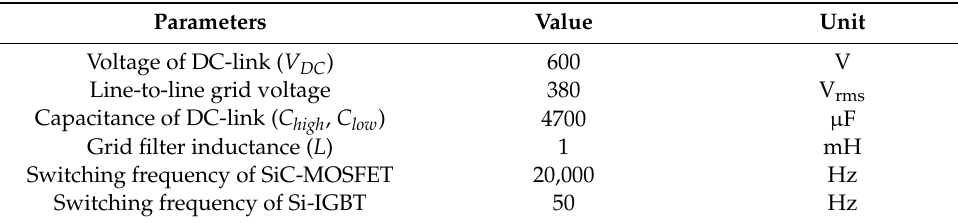
Table 2. Parameters for simulation and experiments.